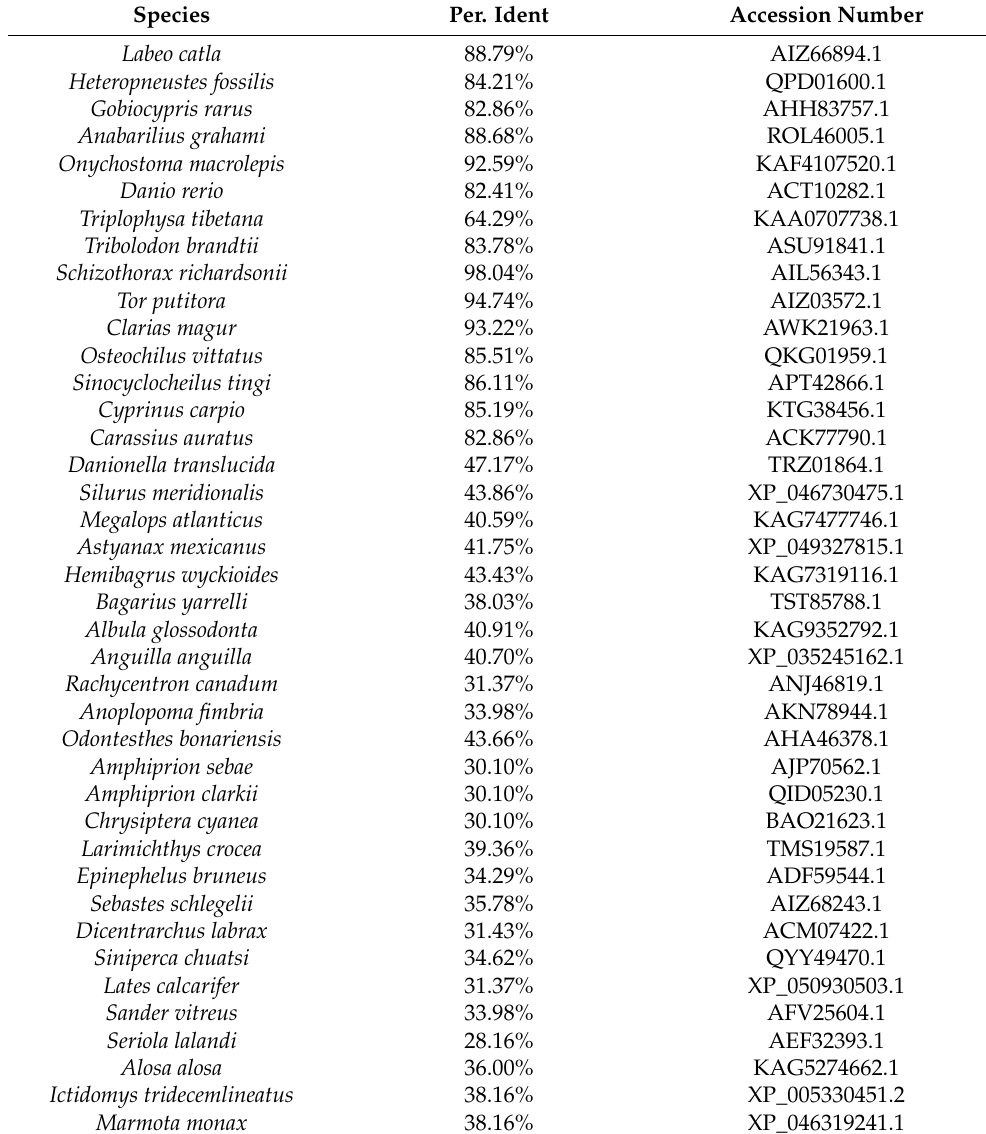
Table 2. Amino acid similarity levels of the kiss1 protein of S. biddulphi with those from other